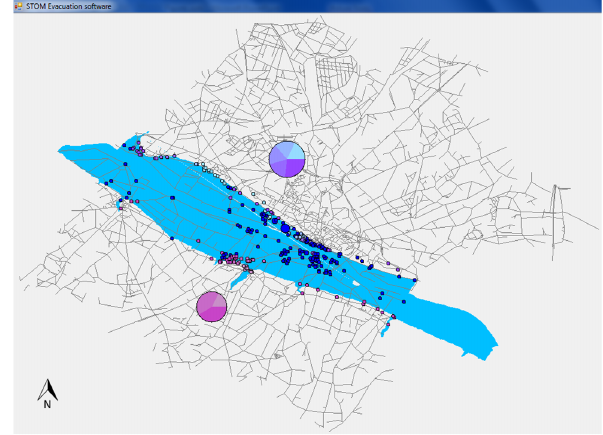
Figure 18. Evacuation of the valley of Gien (each color represents a time slot): construction of the evacuation plan 125h after the be- ginning of the flood.